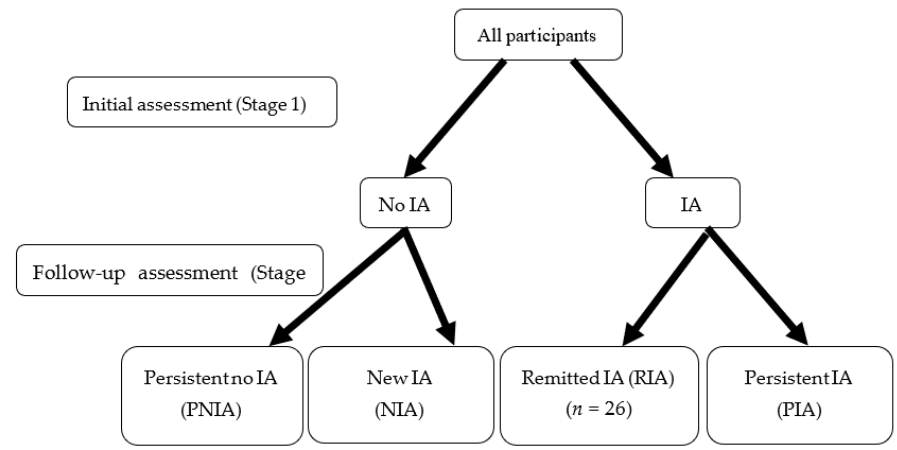
Figure 1. Study participants were assigned to one of four addiction